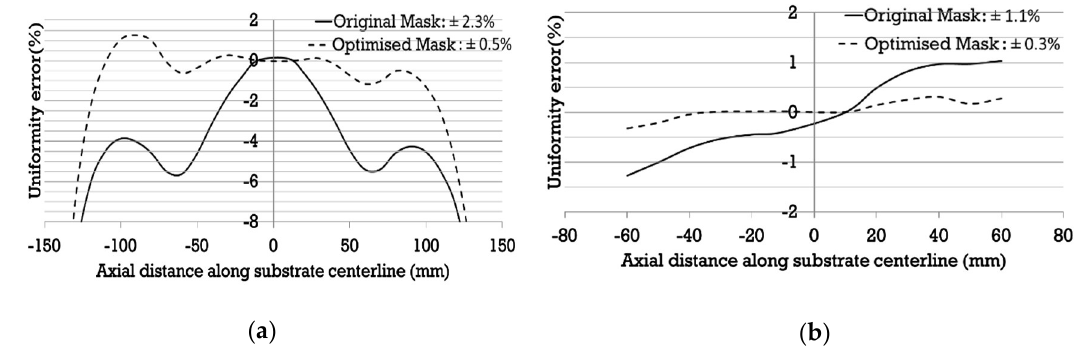
Figure 30. ( a ) Coating uniformity of Nb 2 O 5 film. ( b ) Coating uniformity of SiO 2 film. Figure 30. Coating uniformity of ( a ) Nb